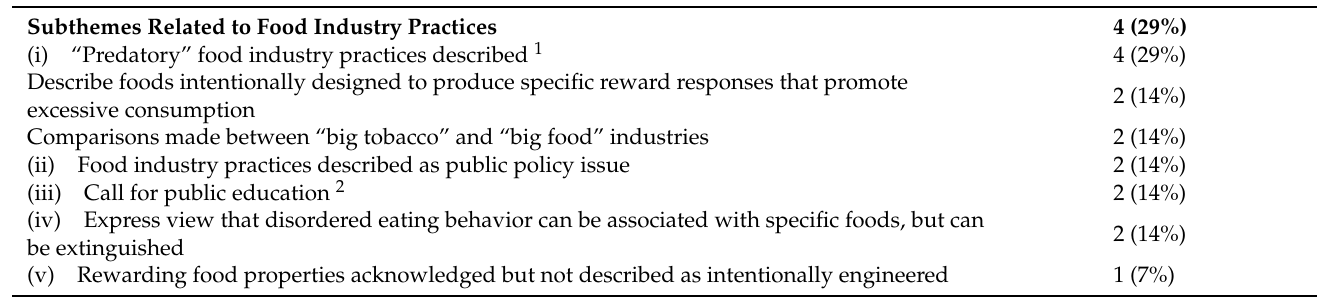
Table 11. Participant responses pertaining to Theme 8, “predatory food industry